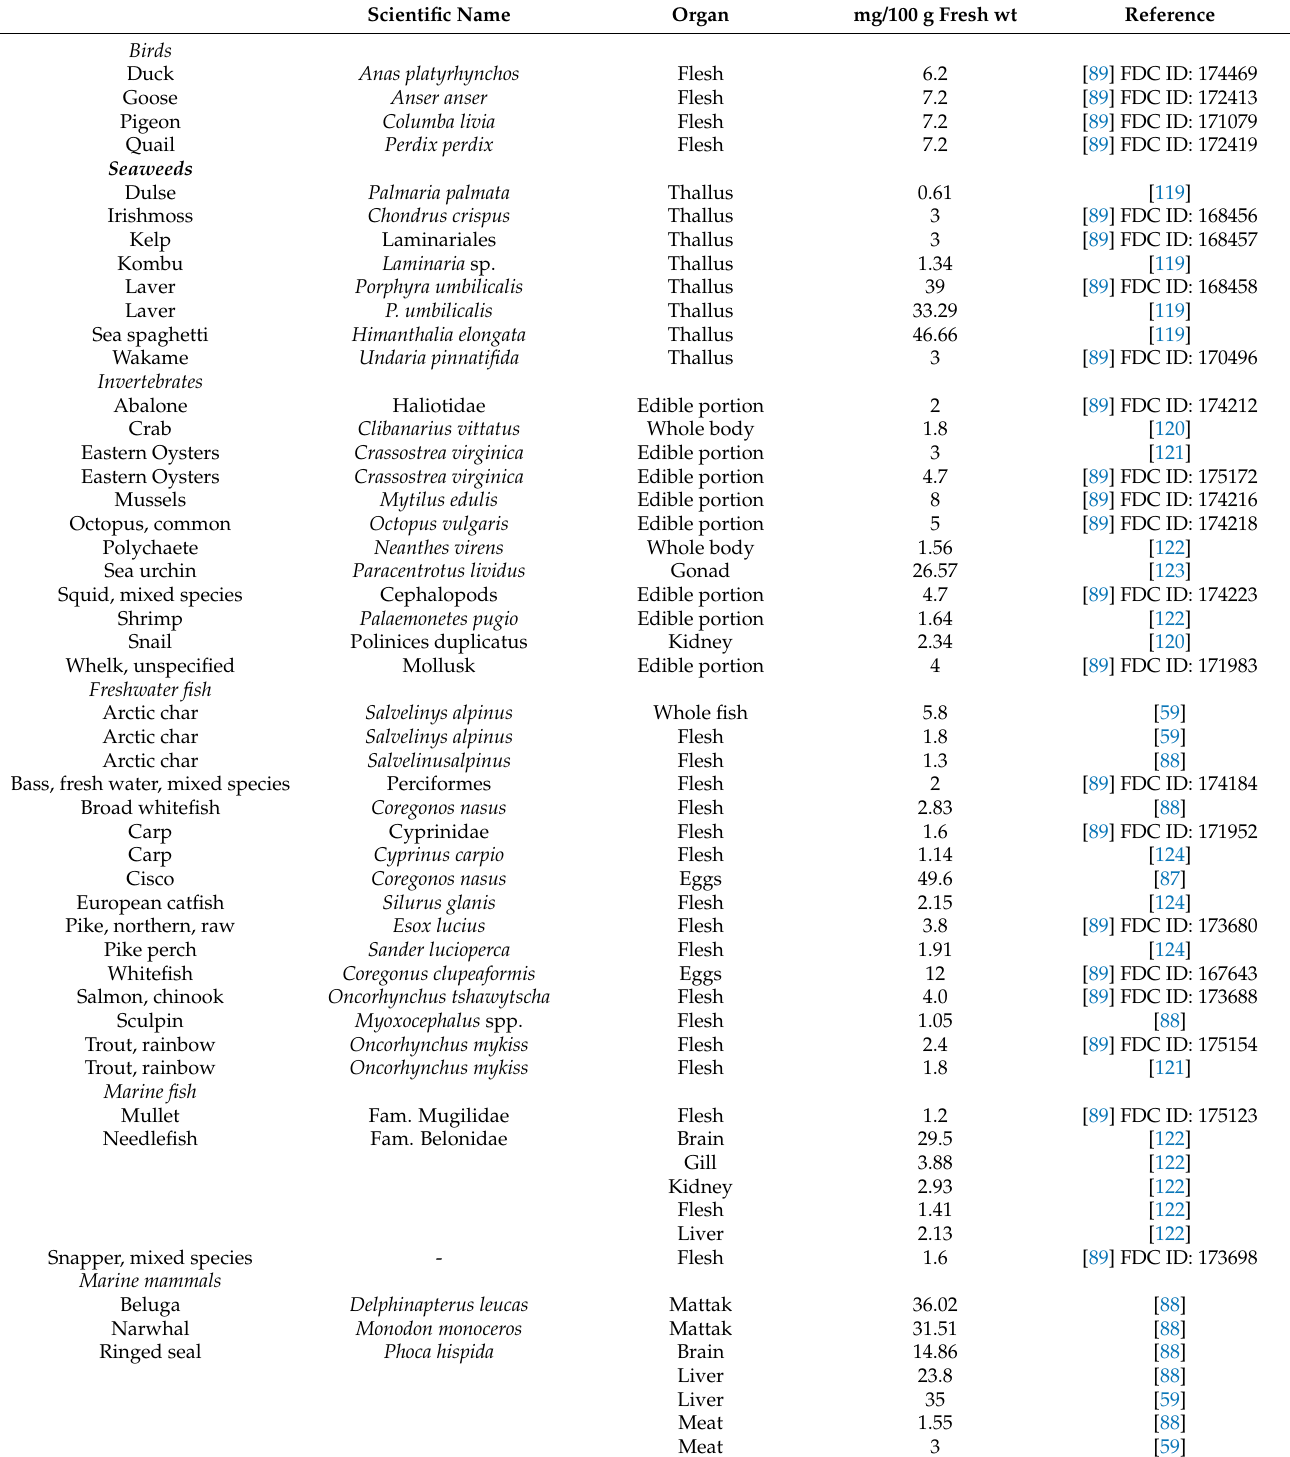
Table 4. Vitamin C contents of birds and aquatic food resources available to Paleolithic